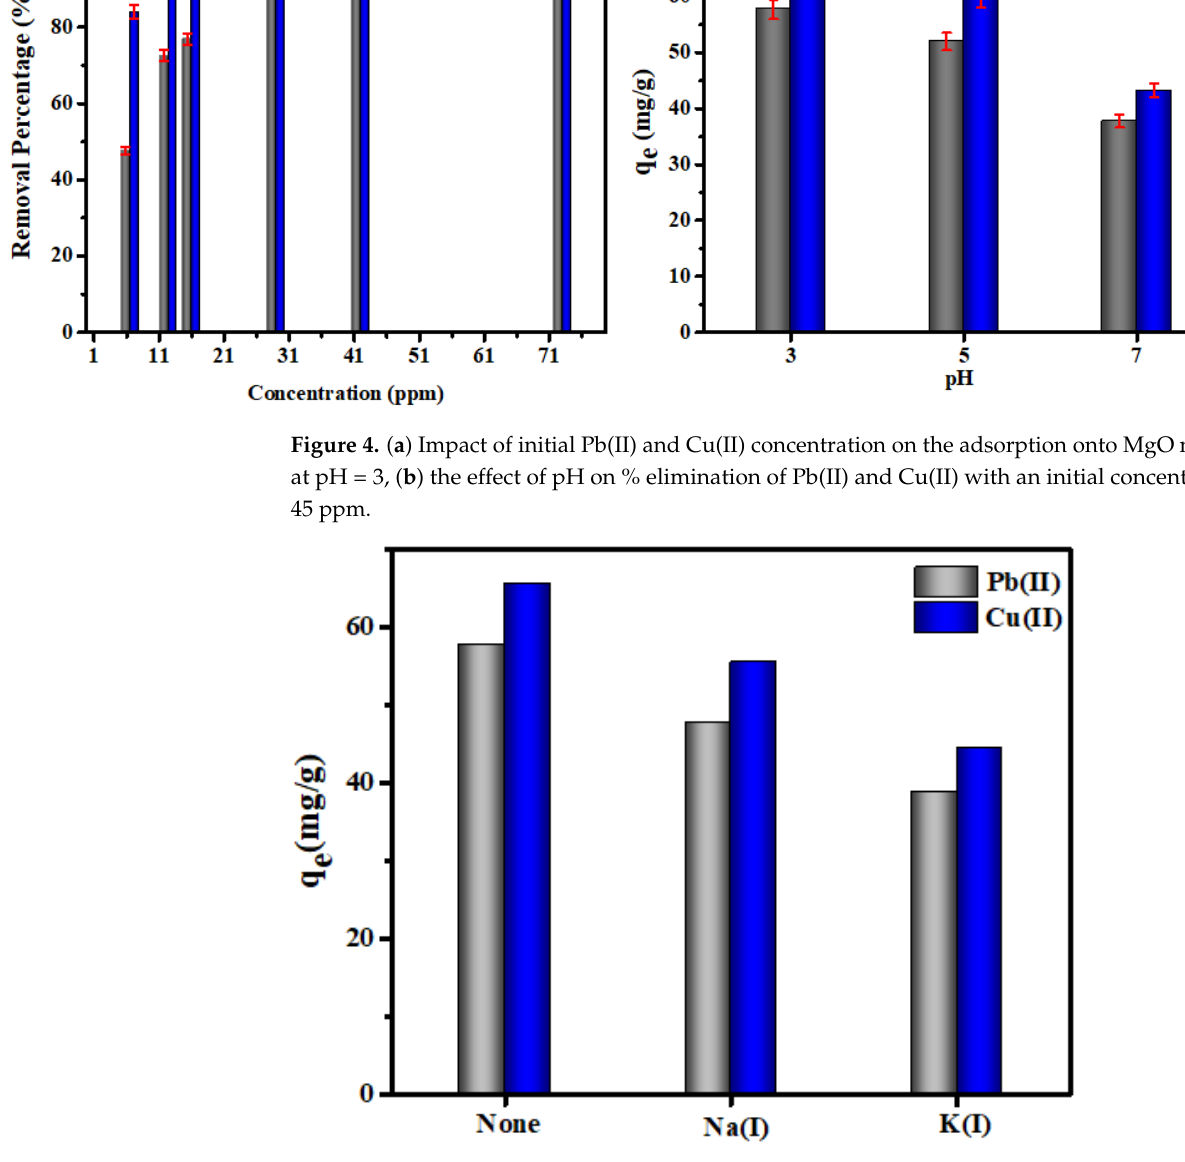
Figure 5. Influence of interfering ions on the adsorption of on Pb(II) and Cu(II) ions using MgO nanorods.